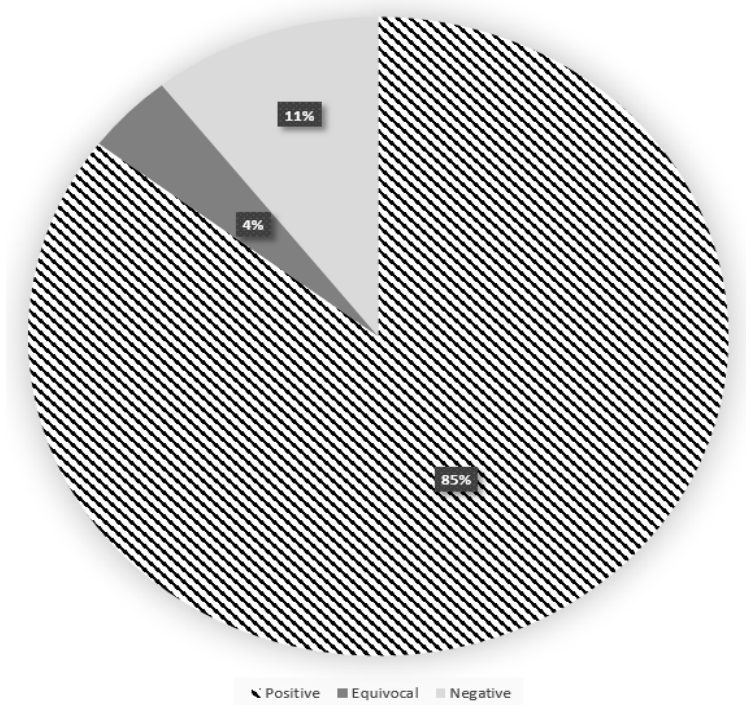
Figure 1. Results of the serological test repeated after 5 months among workers seropositive ( ≥ 15 AU/mL) at the first phase–CSS and UNITO workers.